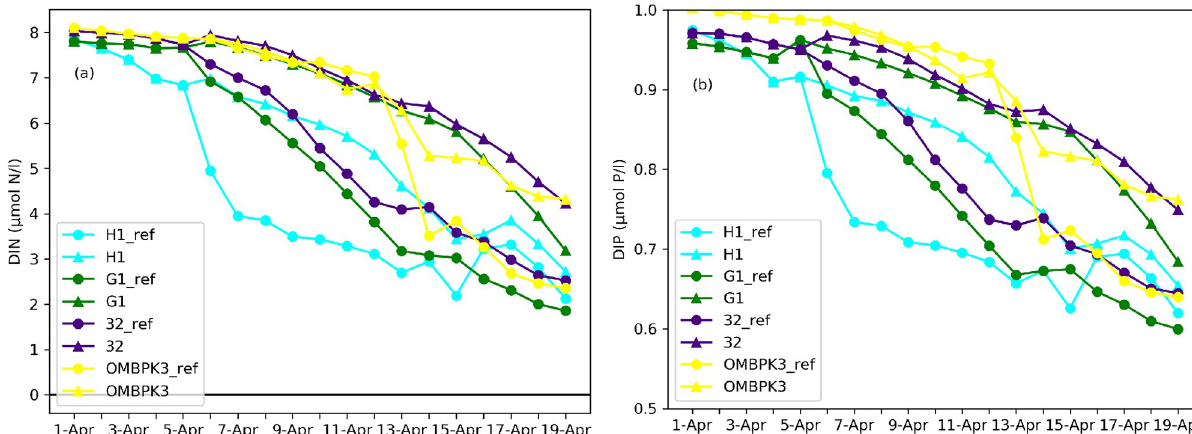
Fig 14. Distribution of nutrients (DIN and DIP) in the reference and the wind reduction run. The reference run is represented by circles, and by triangles in the wind reduction scenario.